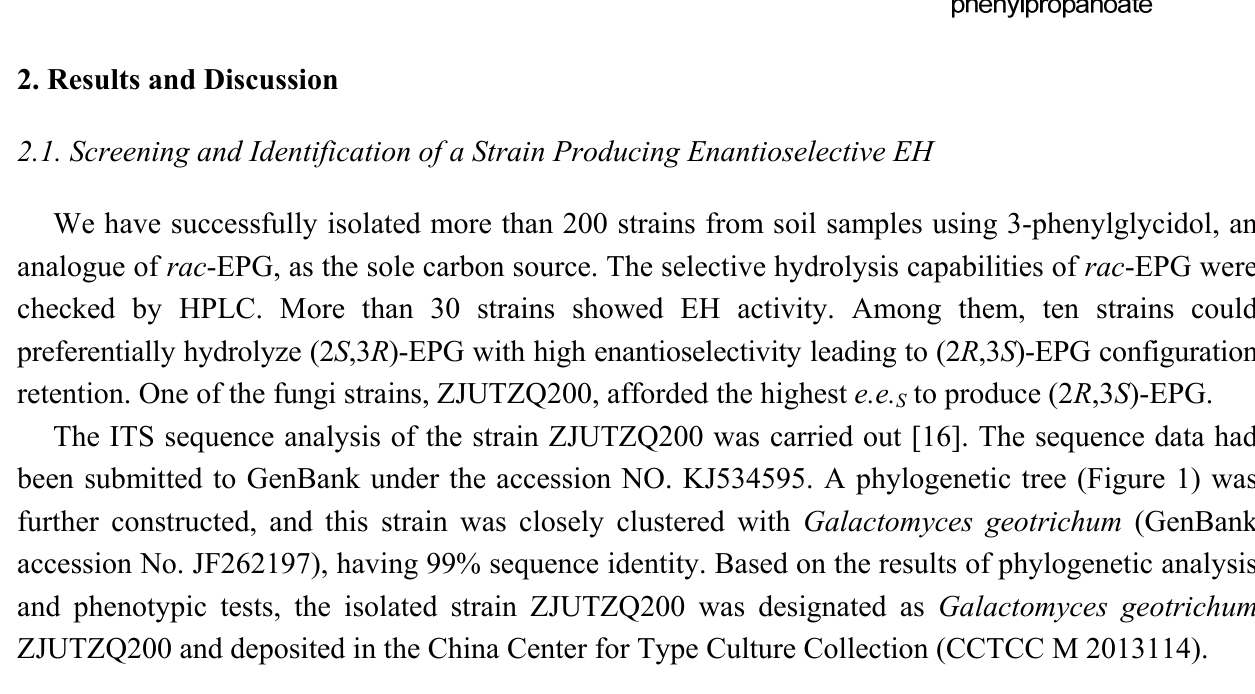
Figure 1. The phylogenetic tree based on 18S-ITS rDNA sequences, constructed by the neighbor-joining method, showing the relationship between the strain ZJUTZQ200 and the representatives of some related